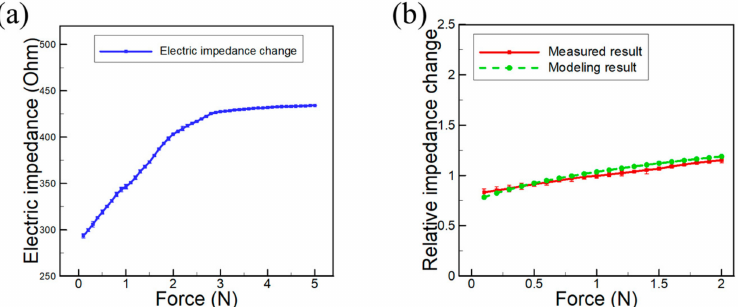
Figure 7. ( a ) Force-sensing test results for bulk crystals with an external force ranging from 0.1 N to 5 N; ( b ) the measured and calculated relative electric impedance shift of the bulk crystal as a function of applied force. Equation (13) was used for the calculated